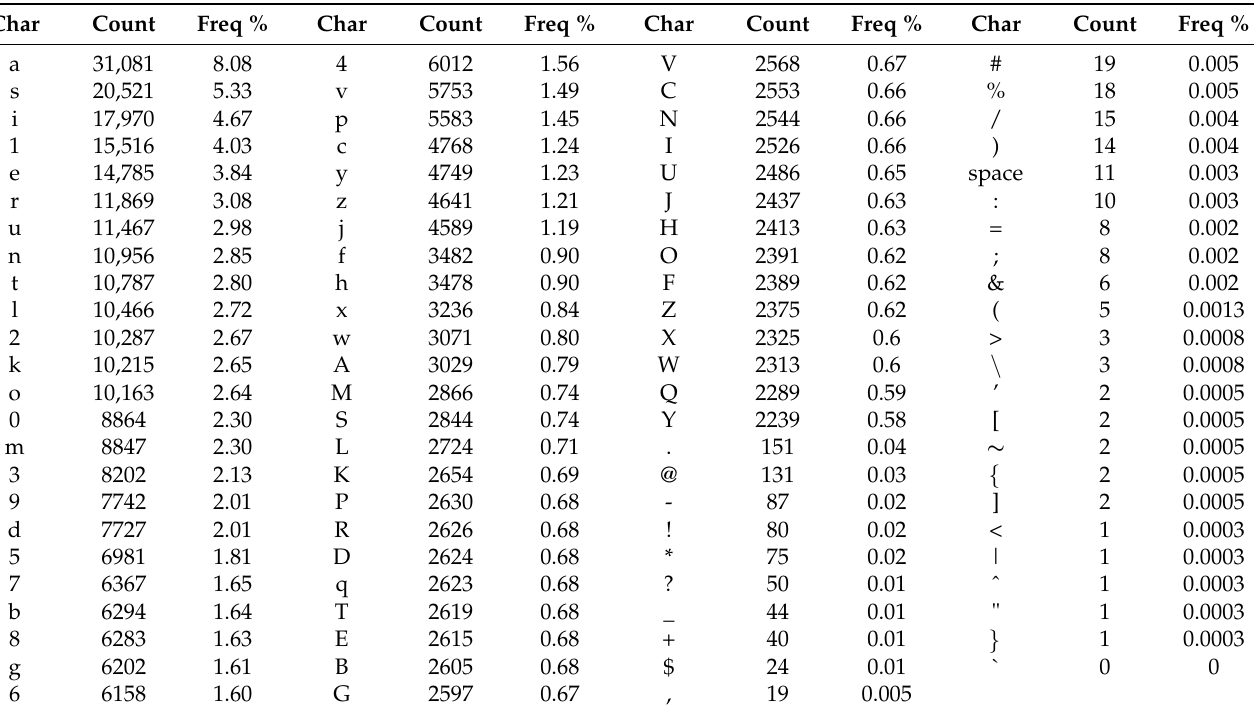
Table 4. Character count and frequency within 50,547 passwords of eight characters or